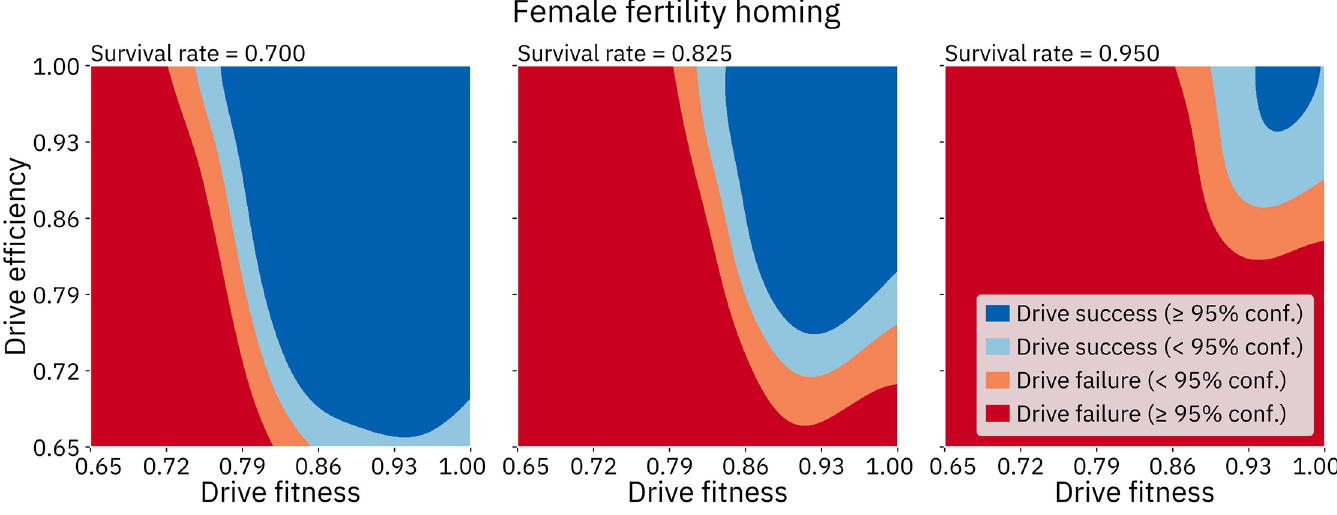
PLOS Computational Biology | https://doi.org/10.1371/journal.pcbi.1009660 December 29,